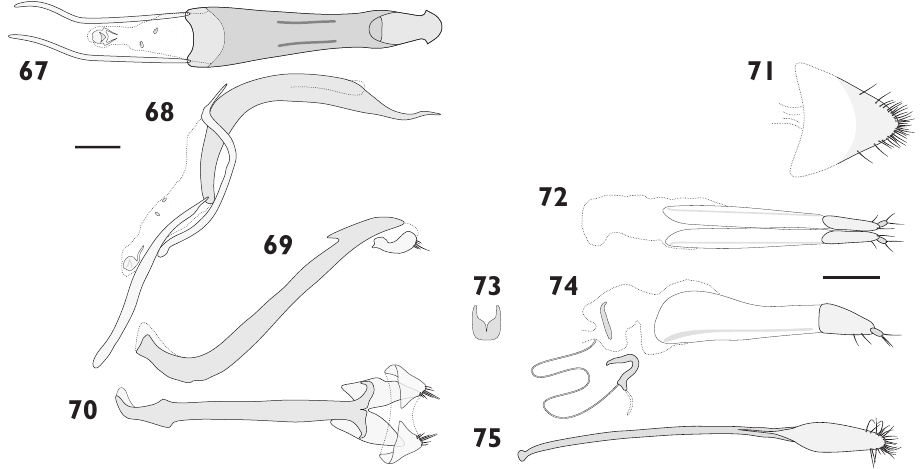
Figures 67–75. Genitalia of Austromonticola planulatus . 67 penis, dorsal view 68 aedeagus, lateral view 69 male hemisternites 8 and spiculum gastrale, lateral view (muscles between hemisternites 8 and basal plate indicated) 70 male hemisternites 8 and spiculum gastrale with basal plate, ventral view 71 tergite 8, dorsal view 72 ovipositor, dorsal view 73 bursal sclerite, anterior view 74 ovipositor and spermatheca, lat- eral view 75 female sternite 8, ventral view. Scale bars = 0.5 mm; 67–70 at same scale; 71–75 at same scale.